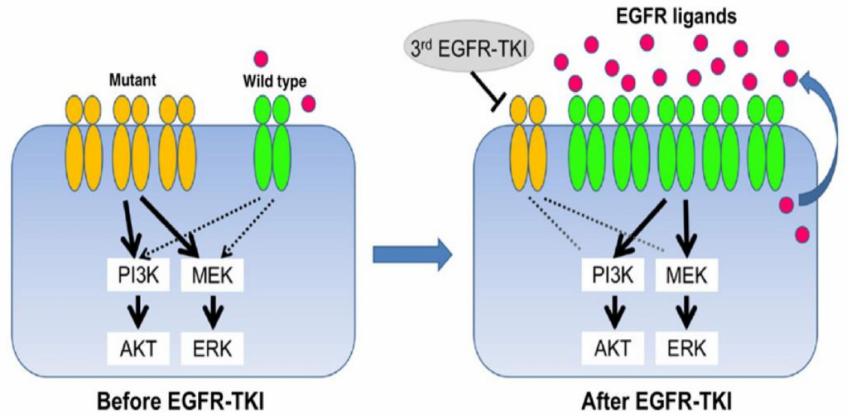
Figure 1. Schematic showing escape from osimertinib growth inhibition by increasing expression of non-mutated EGFR. References in